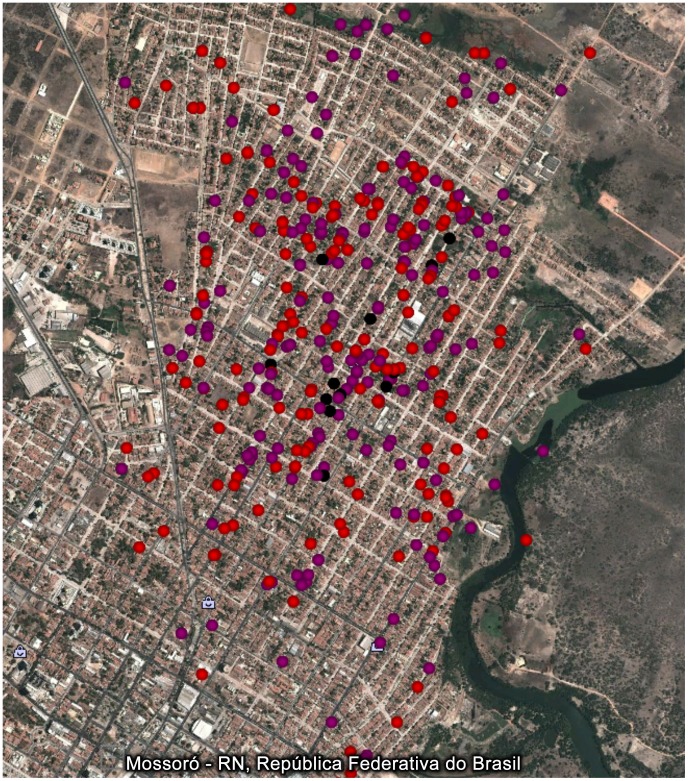
Spatial distribution of new (black) and previous paucibacillary (purple) and multibacillary (red) cases.